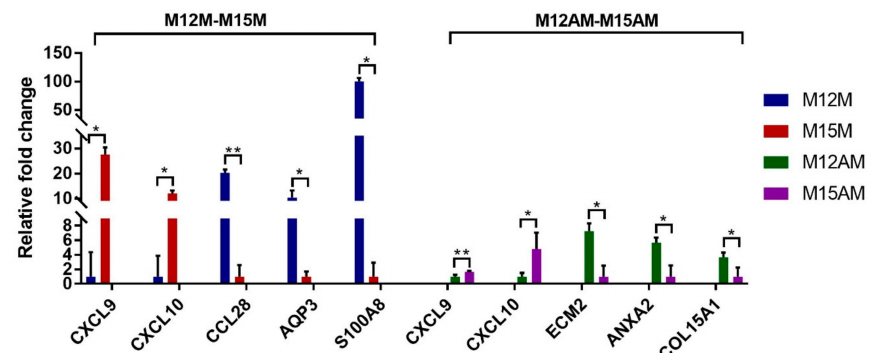
Figure 3. Validation of the di ff erentially expressed genes between gestational days 12 and 15 in the mesometrial endometrium and anti-mesometrial endometrium, respectively. The error bars showed the standard deviation (SD). The p -value was calculated using the t -test. * p < 0.05; ** p < 0.01. M12M, gestational day 12 at the mesometrial side of the uterus; M12AM, gestational day 12 at the anti-mesometrial side of the uterus; M15M, gestational day 15 at the mesometrial side of the uterus; M15AM, gestational day 15 at the anti-mesometrial side of